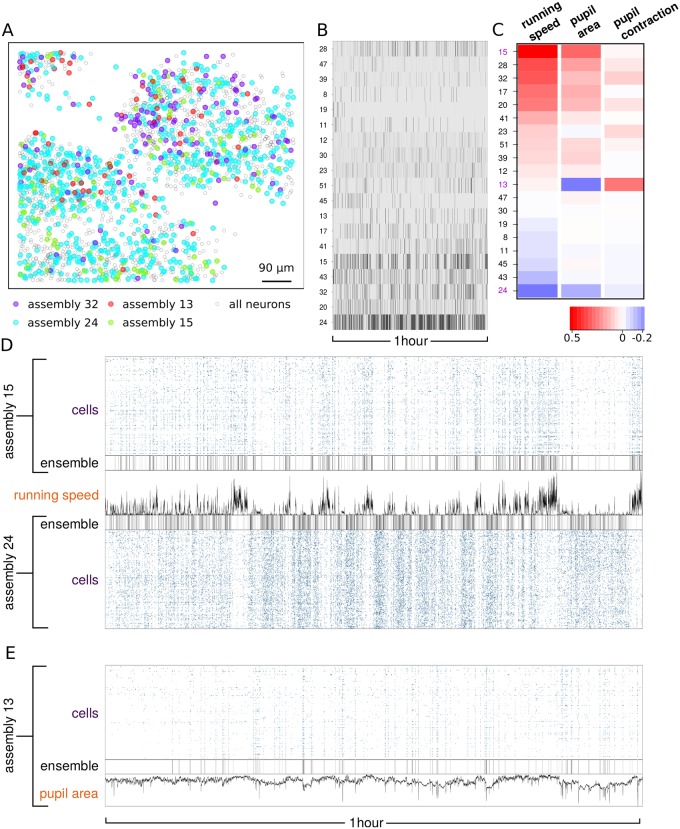
Neuronal assemblies from functional imaging of the mouse cortex.(A) 2D spatial distribution of neurons recorded from the mouse visual cortex from Ref. [19]. The color code represents selected assemblies obtained with our method. (B) Assembly activity matrix. (C) Correlation between the activity of each assembly and (from left to right) the time course of running speed, pupil area and the (binarized) pupil contraction. (D) Correlation and anti-correlation of neuronal assemblies with respect to running speed. (E) Assembly correlated with pupil contraction.